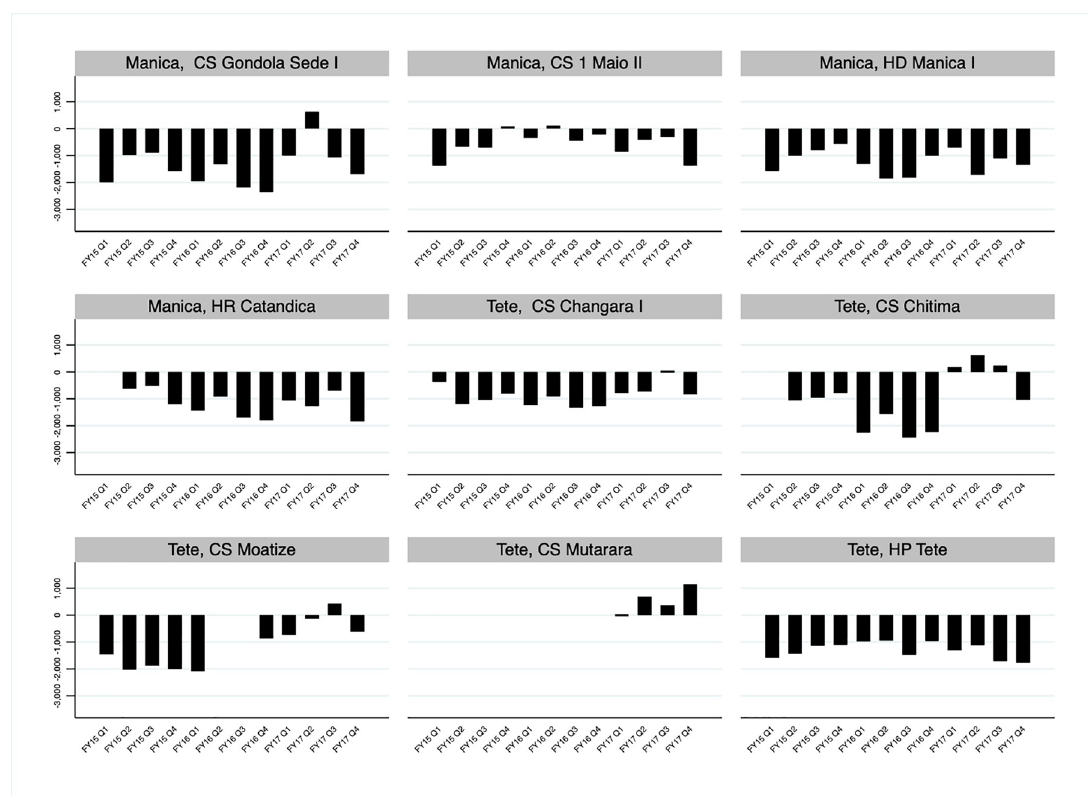
Fig 8. Productivity gains and losses for fixed voluntary medical male circumcisions (VMMCs) service delivery sites in Manica and Tete, Mozambique FY15 Q1- FY17 Q4. Productivity gains and losses are calculated for fixed service delivery sites and associated outreach sites. The productivity gain/loss is the number of VMMCs performed minus the number of VMMCs the site could have performed at optimum site capacity.